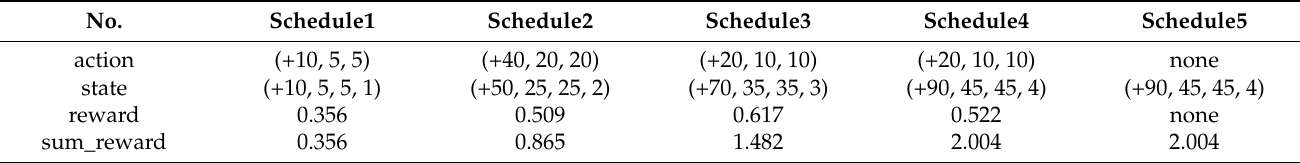
Table 6. Electric fence scheduling strategy based on reinforcement learning during working days.